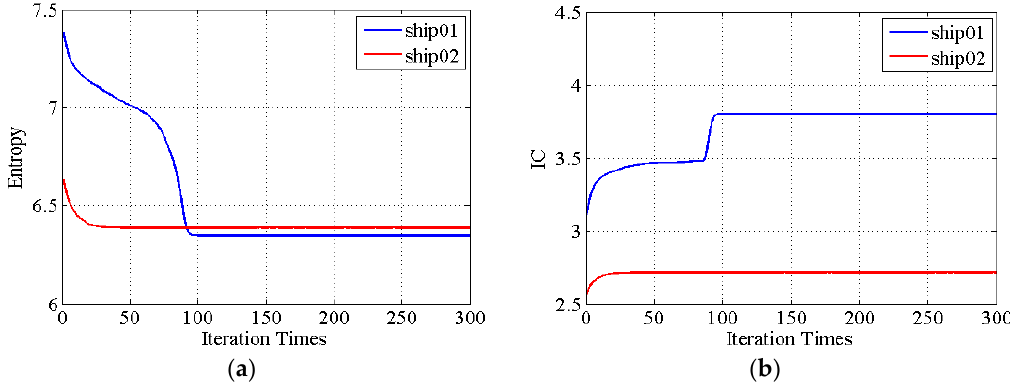
Figure 8. The entropies and IC values convergence of two sub-images versus the number of iterations. ( a ) Entropies change of the two sub-images during iteration; ( b ) IC values change of the two sub-images during iteration.